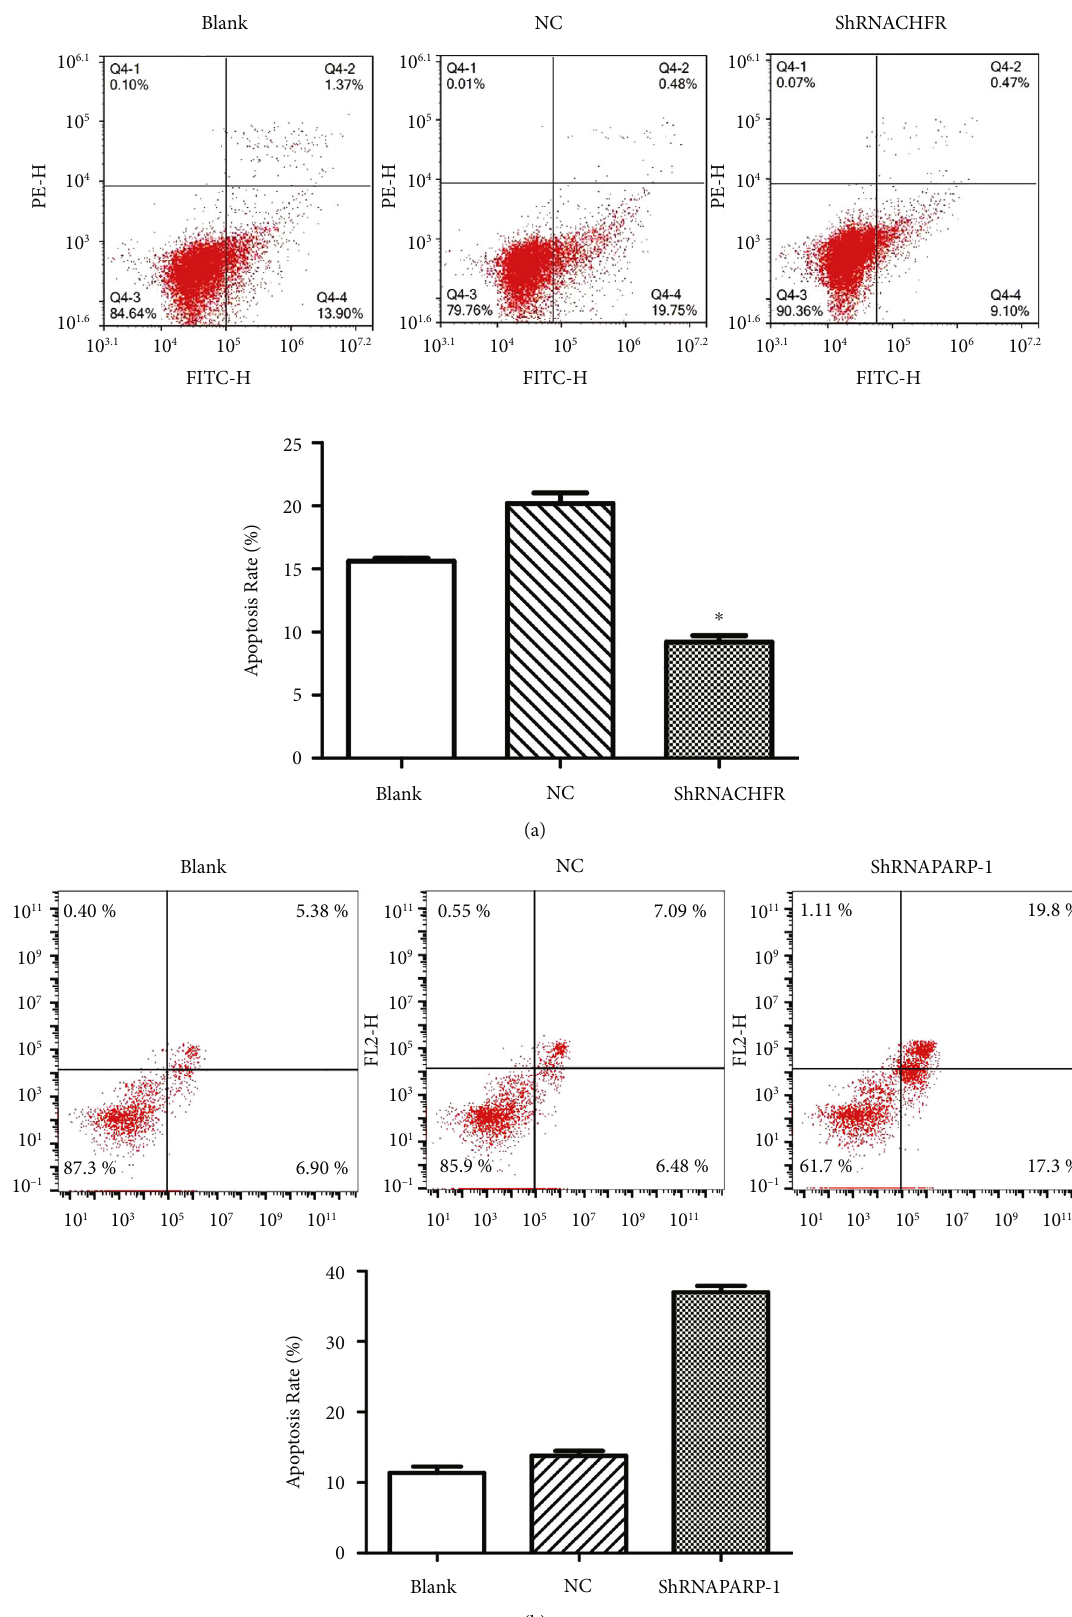
Figure 5: The e ff ects of CHFR and PARP-1 on the cell apoptosis of Raji cells. The cell apoptosis of Raji cells after the cells ’ transfection with sh- CHFR (a) and sh-PARP-1 (b) lentivirus for 24 and 48 hours measured using fl ow cytometry. * P < 0 : 05 , compared with the blank